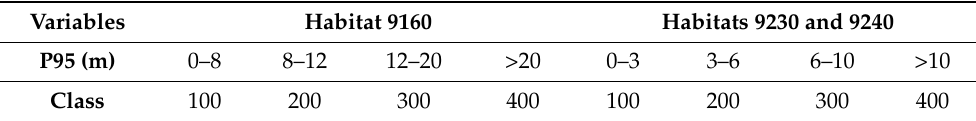
Table 2. Ranges established for the variable P95 (m). Additionally, 9160 is Quercus robur habitat, 9230 is Quercus pyrenaica habitat, and 9240 is Quercus faginea